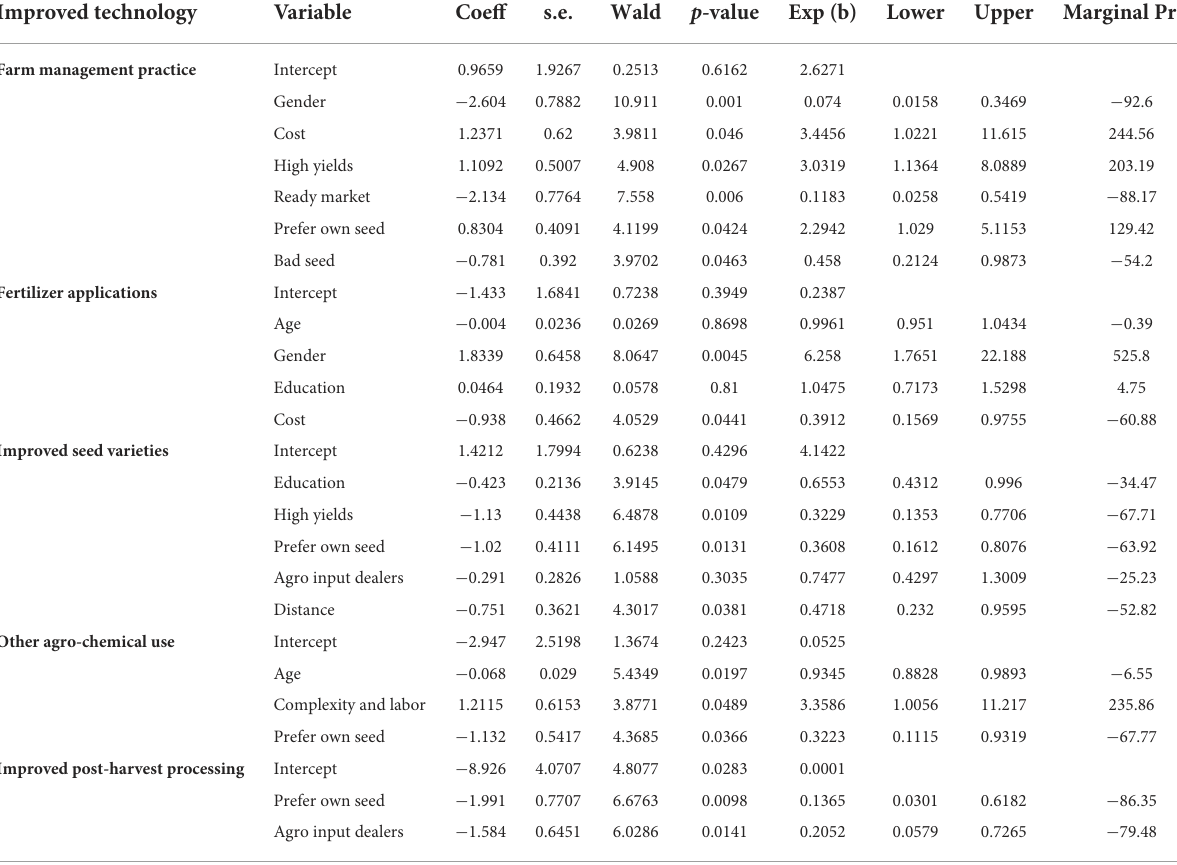
TABLE 6 Aggregated summary of table of logistic results for different types of improved